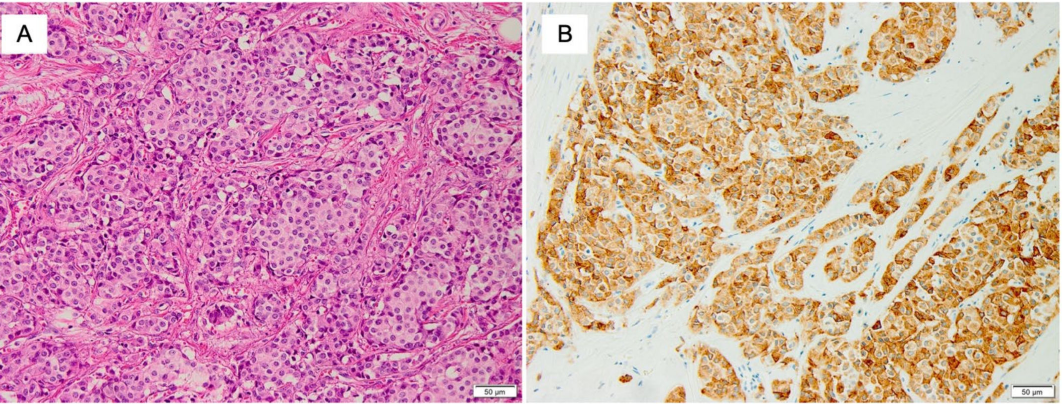
Figure 4. Morphological and immunohistochemical features of NET of the breast. Neuroendocrine tumor (NET) of the breast characterized by closely packed nests of cells with round and uniform nuclei. ( A ) H & E staining ( × 200); ( B ) positive immunostaining for synaptophysin ( × 200) (Pictures by